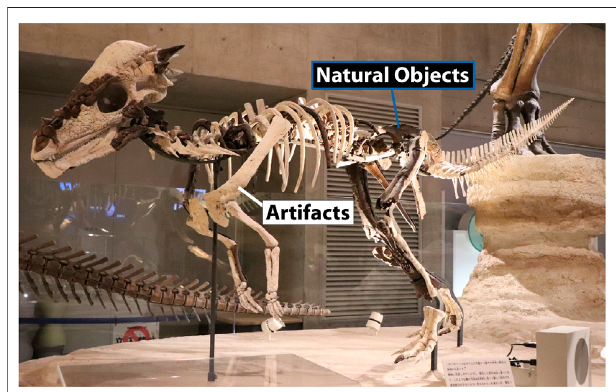
FIGURE 2 | A skeleton of Pachycephalosaurus wyomingensis (NMNS PV20423) in Evolution of Life, Exploring the Mysteries of Dinosaur Evolution, Global Gallery. Dark brown parts are original fossils. White parts are